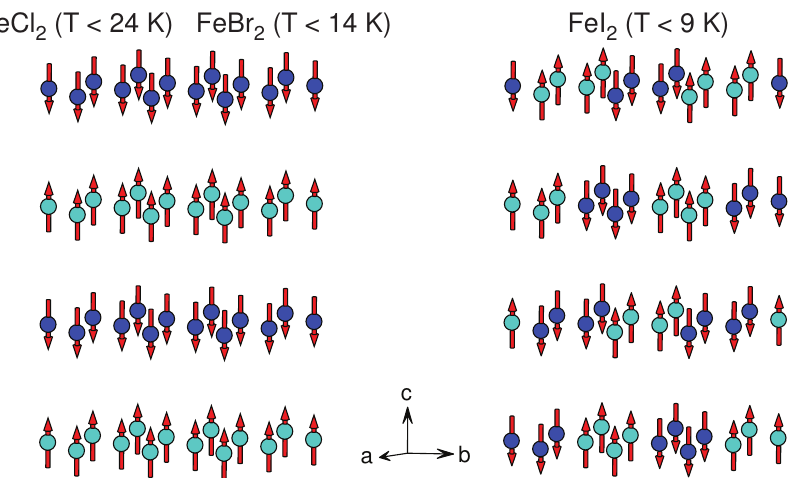
Figure 6. The magnetic structures of Fe X 2 with the hexagonal coordinate system of the underlying crystal lattice shown. All moments are along either the + c or - c